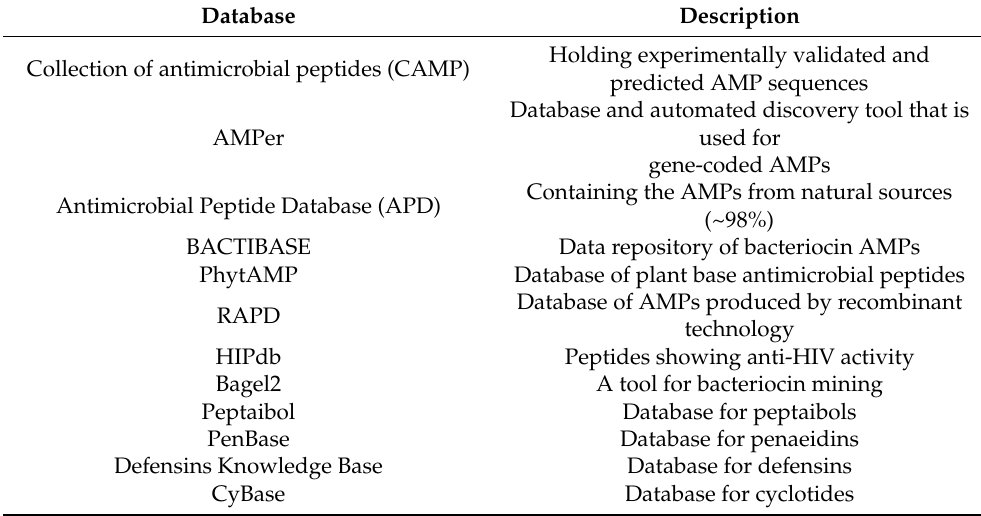
Table 2. Current availability of antimicrobial peptides (AMPs) databases [81]. Database Description Holding experimentally validated and Collection of antimicrobial peptides (CAMP) predicted AMP sequences Database and automated discovery tool that is AMPer used for gene-coded AMPs Containing the AMPs from natural sources Antimicrobial Peptide Database (APD) (~98%) BACTIBASE Data repository of bacteriocin AMPs PhytAMP Database of plant base antimicrobial peptides Database of AMPs produced by recombinant RAPD technology HIPdb Peptides showing anti-HIV activity Bagel2 A tool for bacteriocin mining Peptaibol Database for peptaibols PenBase Database for penaeidins Defensins Knowledge Base Database for defensins